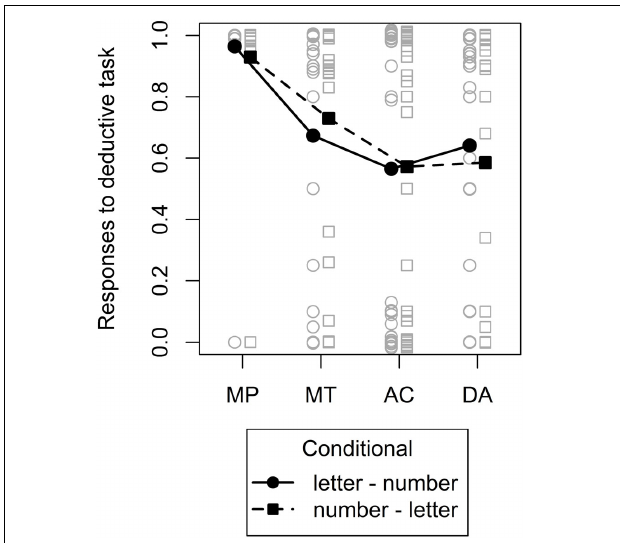
FIGURE 4 | Mean (filled symbols) and individual (non–filled symbols) responses to the deductive conditional inference task. The two different conditionals are depicted by different lines and symbols. A small amount of vertical jitter was added to individual responses in case of perfect overlap to make points